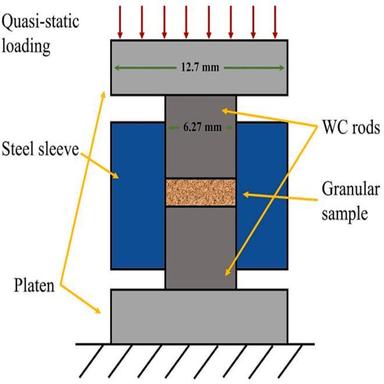
Schematic of quasi-static powder compaction fixture. The powder is sandwiched in a steel sleeve between two tungsten carbide rods. The setup can introduce uni-axial strain loading to the confined powders.